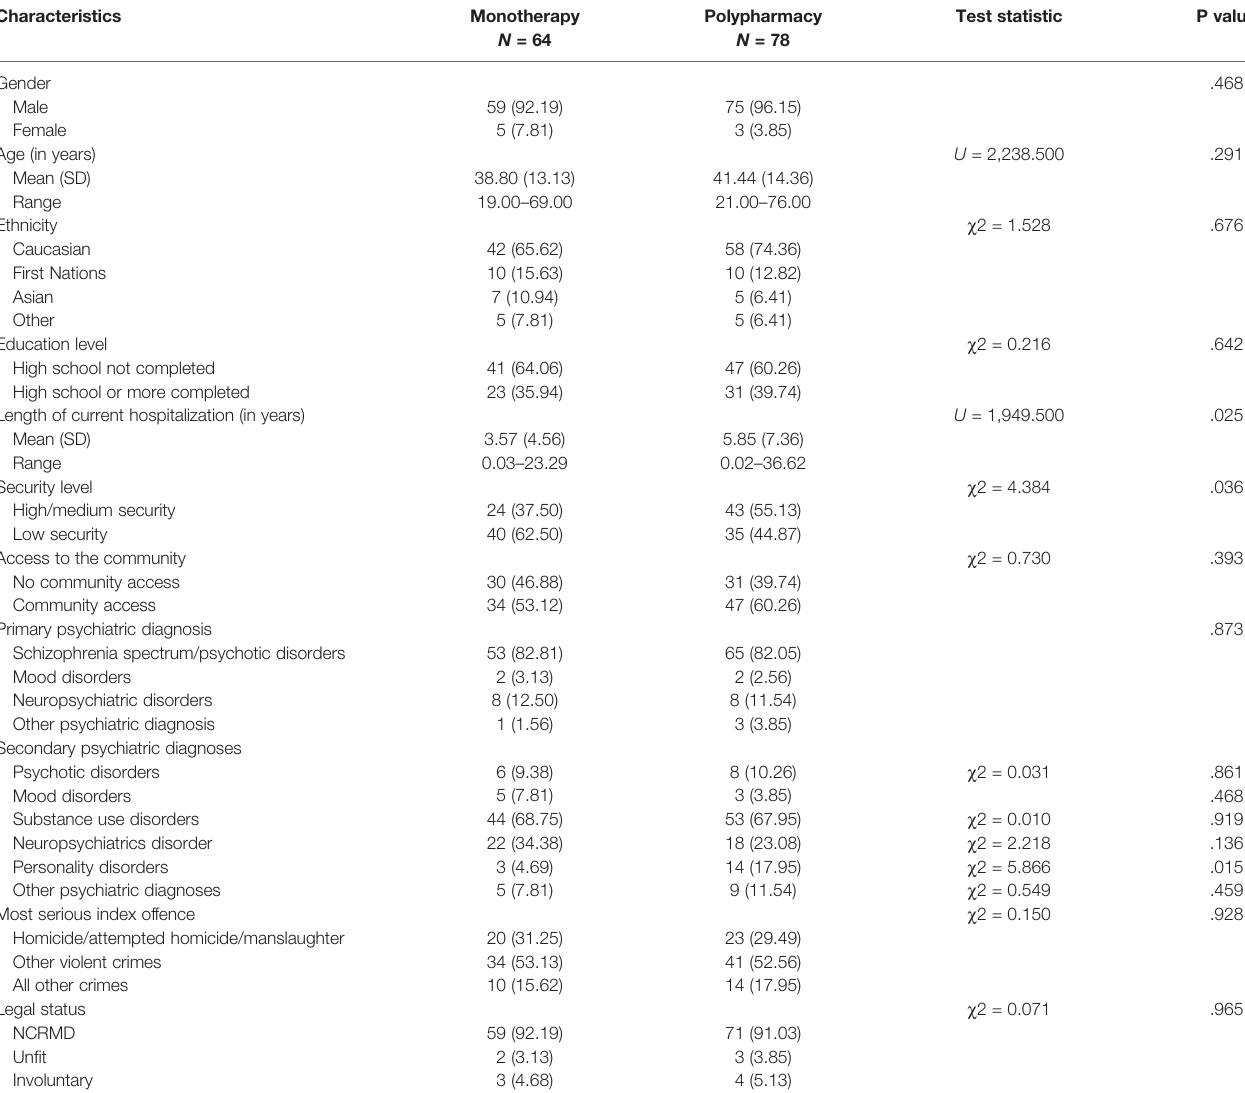
TABLE 3 | Associations between demographic, clinical, and forensic variables and exposure to antipsychotic polypharmacy.